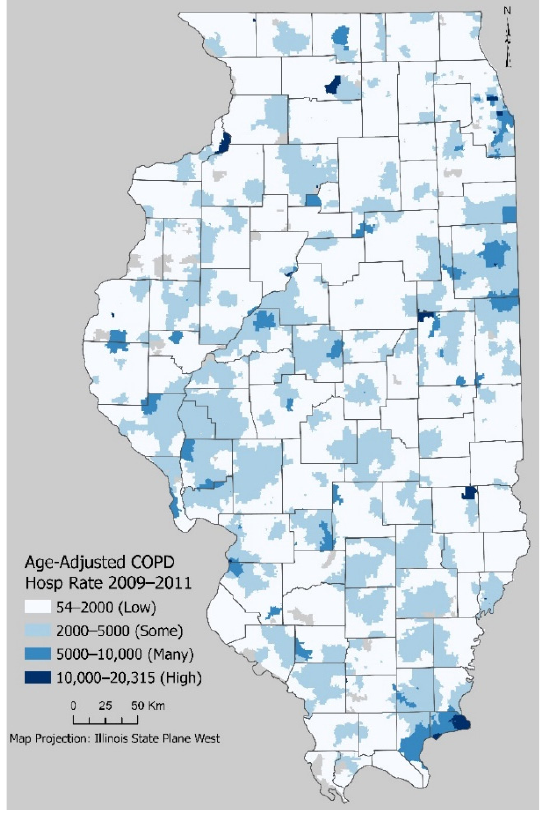
Figure 2. COPD Age-Standardized Hospitalization Rate per 100,000.